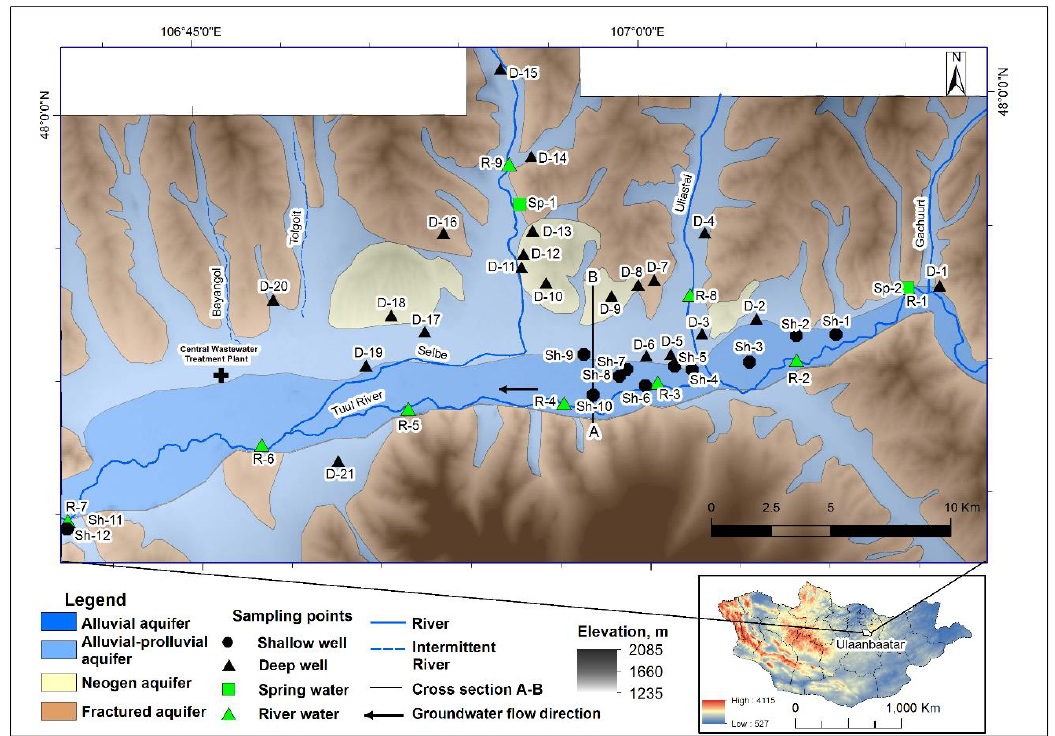
Figure 1. Hydrogeological map of Ulaanbaatar (UB) and the sampling locations (modified from a 1:200,000 hydrogeological map [10]).